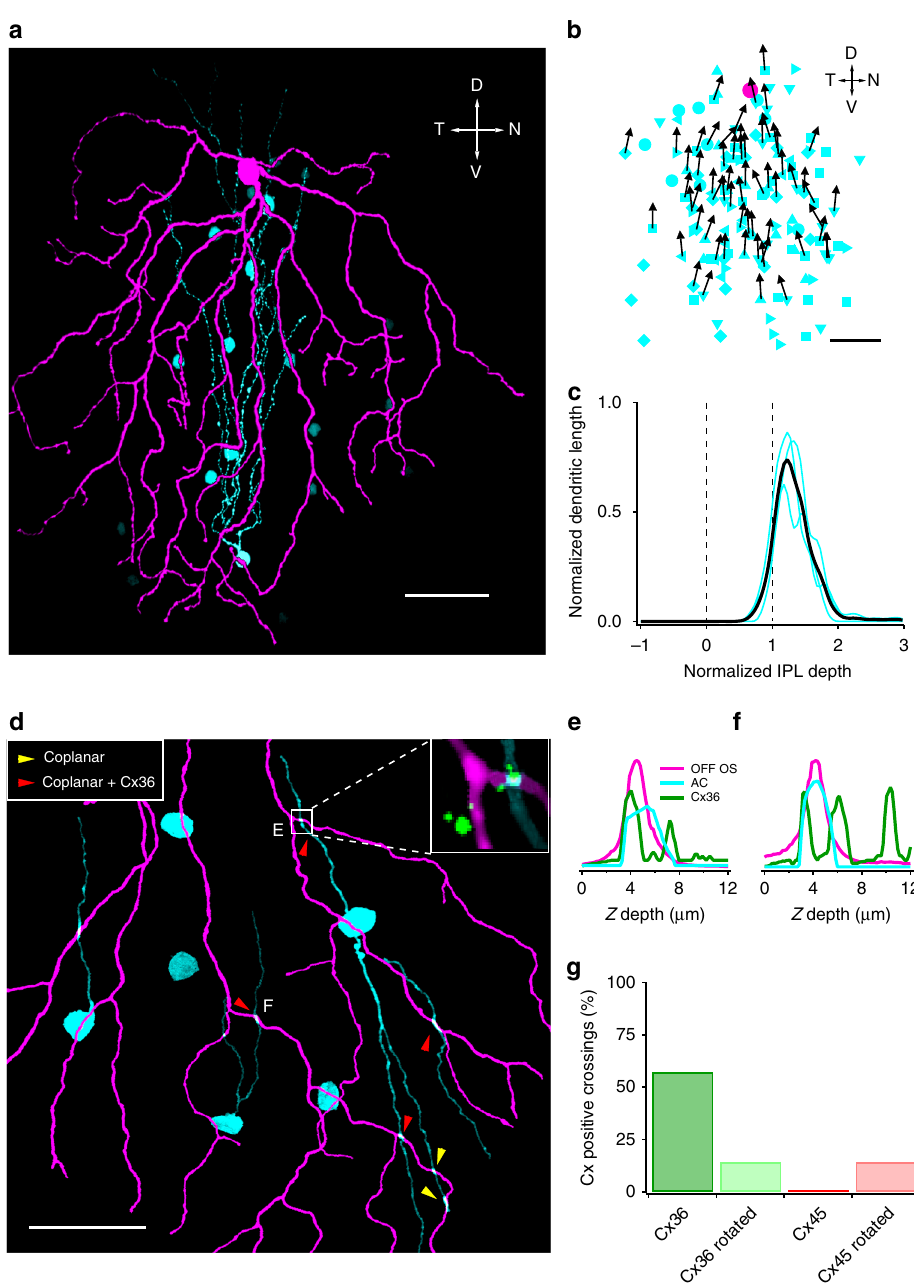
Fig. 3 Electrical coupling between OFF OS RGCs and amacrine cells. a OFF OS RGC (magenta) and neurobiotin coupled amacrine cells (cyan). One of the coupled cells is traced. Scale bar = 50 μ m. b Positions of amacrine cells coupled to OFF OS RGCs (cyan symbols). Different cyan symbols indicate cells from different experiments ( n = 131 cells total from seven RGCs). Amacrine cells are plotted with respect to the RGC (magenta circle). Directions of primary dendrites are shown in black arrows when they were visible. Scale bar = 50 μ m. c Strati fi cation of coupled amacrine cells dendrites in IPL. Cyan lines indicate pro fi les of individual amacrine cells. Black line represents mean across three cells. Dotted lines indicate ON and OFF starburst planes. The inner nuclear layer (INL) is located to the right and the ganglion cell layer (GCL) is located to the left. d Magni fi ed view of an OFF OS (magenta) and amacrine cell (cyan) coupled network. Yellow and red arrowheads indicate coplanar dendrite crossings and coplanar dendrite crossings positive for connexin 36 (Cx36). Inset shows an example crossing with Cx36 puncta. Scale bar = 50 μ m. e , f Z -axis pro fi les of fl uorescent intensities for OFF OS, amacrine cell dendrites and Cx36 puncta. g Percentage of coplanar crossings that are connexin positive. A total of 58% (4/7) coplanar crossings were Cx36 positive and 0% (0/7) were Cx45 positive. A total of 14% (1/7) coplanar crossings were positive for either Cx36 or Cx45 when the connexin channels were rotated by